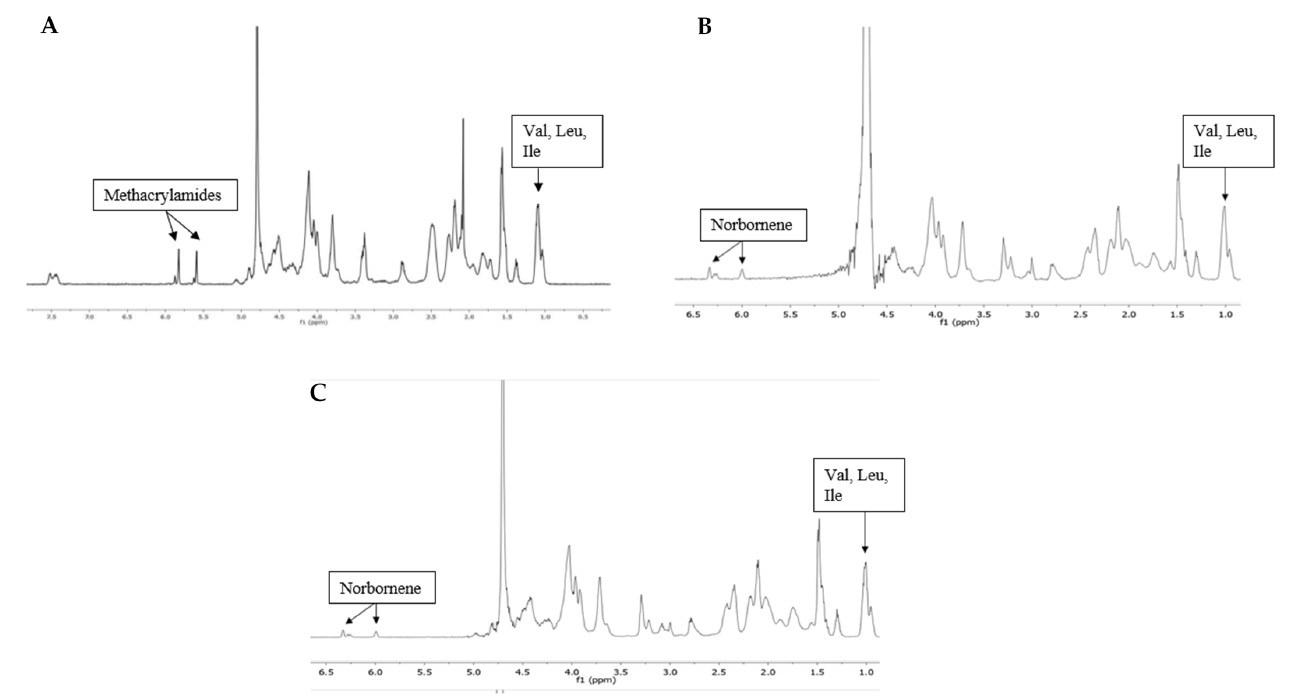
Figure 3. To confirm the degree of substitution, 1 H-NMR spectra were assessed of ( A ) Gel-MA DS 97%, ( B ) Gel-NB DS 85%, and ( C ) Gel-NB DS 55%. Gel-MA: methacrylated gelatin; gel-NB: norbornene-functionalized gelatin.